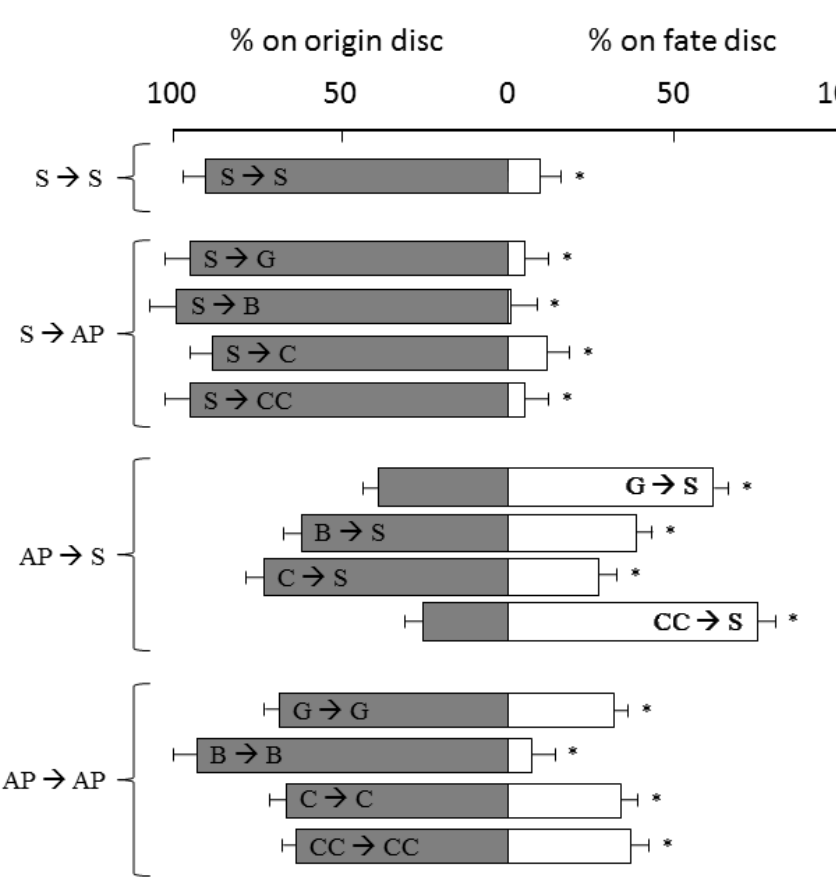
Figure 4. Tetranychus urticae settlement on strawberry (S) or aromatic plants (AP) leaves (Basil— Ocimum basilicum (B), Chives— Allium schoenoprasum (C), Garlic— Allium sativum (G), Chinese chives— Allium tuberosum (CC)), 24 h after mite release. Bars ( ± Standard deviation) followed by an asterisk (*) denote significant differences by Mann – Whitney U-tests ( p < 0.01) between % of TSSM on origin versus fate disc.